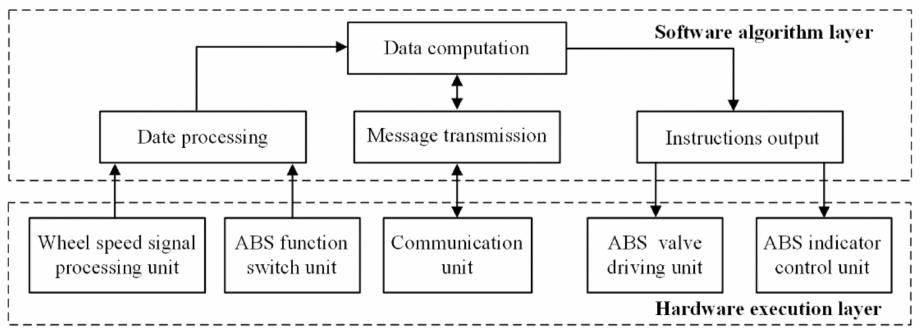
Figure 1. Framework of a pneumatic ABS controller.